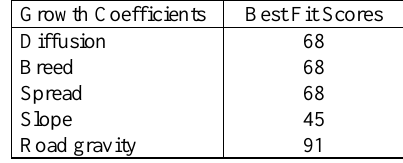
Table 2. The best fit scores of growth coefficients